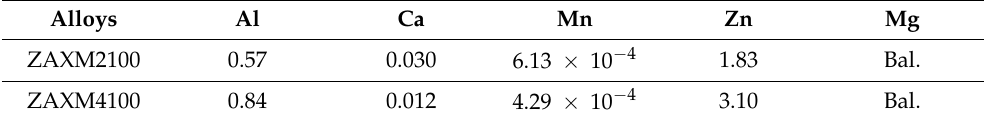
Table 4. Calculated amount (in wt.%) of dissolved alloying elements in matrix of ZAXM2100 and 4100 alloys calculated by using a thermodynamic software